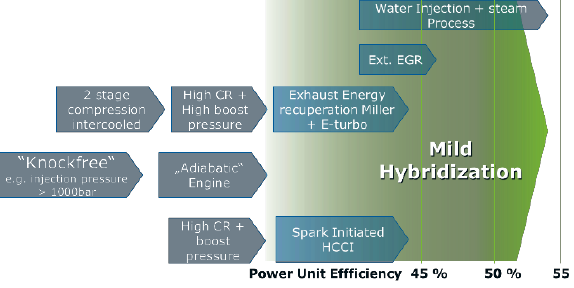
Fig. 16. Technology approaches for further increased efficiency of the Gasoline